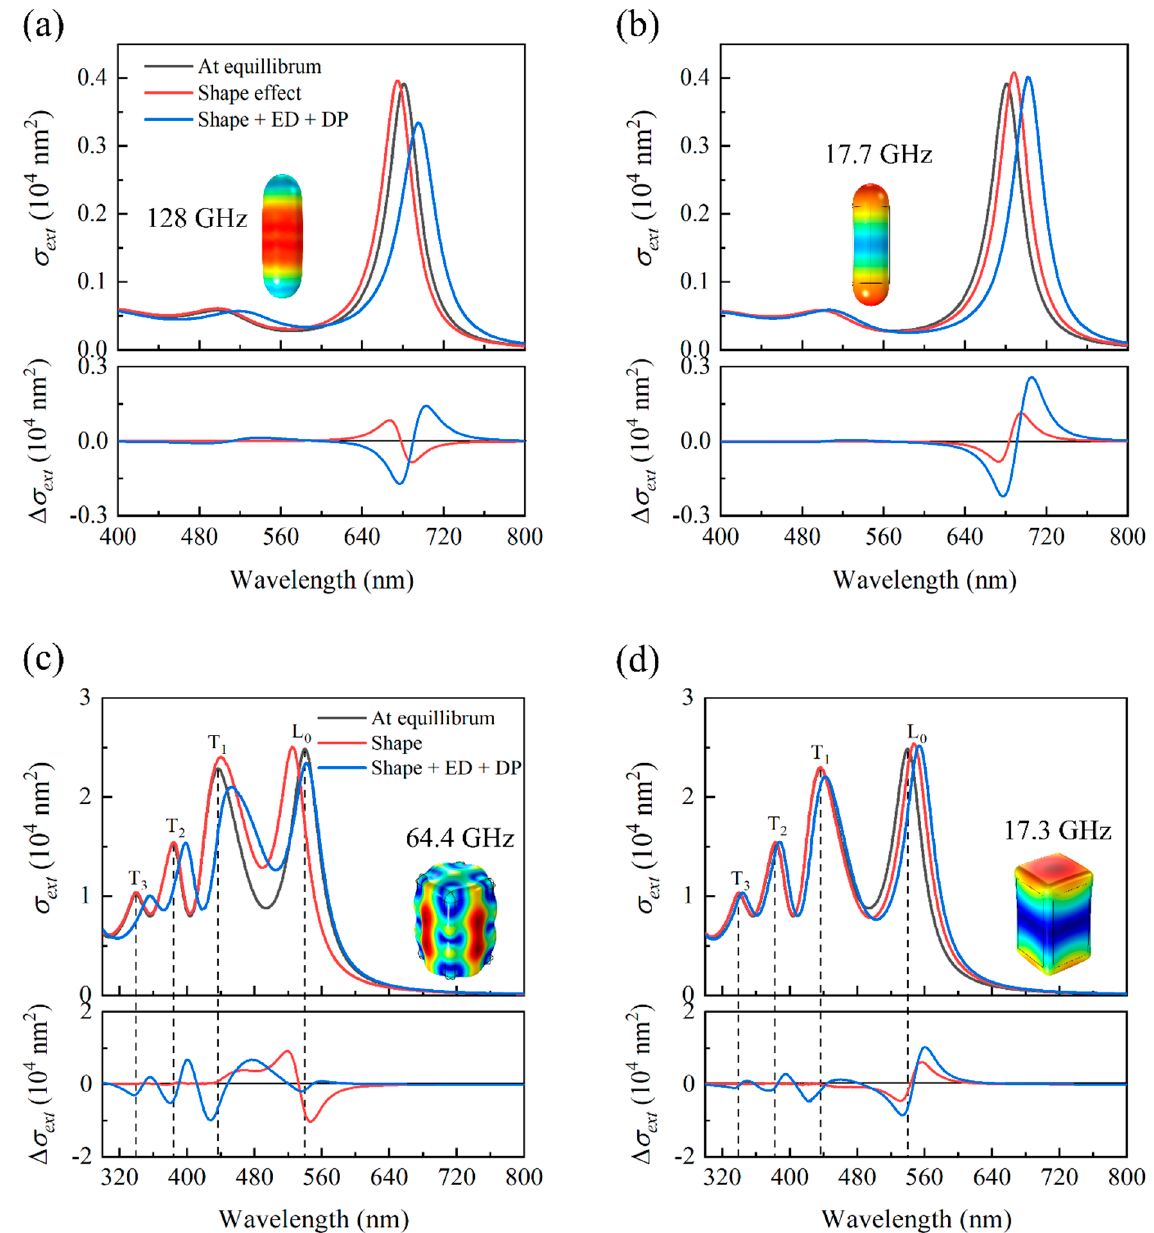
Figure 6. Simulated acoustic vibration induced modifications of the optical properties of a AuNR ( a , b ) and a rounded ( R = 4 nm) AuNR@Ag 4eq NP ( c , d ) due to the effects of the only opto-mechanical (red curves) and the total (opto-mechanical and photo-elastic, blue curves) couplings. The black curves correspond to the spectra of the NP at equilibrium. The upper panels in ( a – d ) depict the calculated extinction cross-section spectra of the AuNR at the maximum of the expansion phase of its breathing ( a ) and extensional ( b ) modes, and of the AuNR@Ag 4eq NP at its mode 1 ( d ) and mode 4 ( c ). The 3D shape that corresponds to the vibration mode under consideration is also shown as an inset in each upper panel. The lower panels from ( a – d ) correspond to the deviation of the NP extinction cross-sections from their value at equilibrium, induced by the acousto-plasmonic